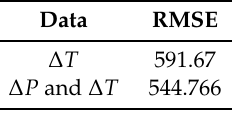
Table 8. Comparison of RMSE value of ∆ P and ∆ T as partial real information.